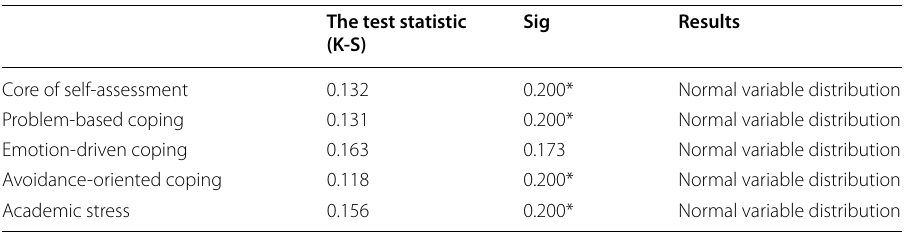
Table 3 Evaluation of normality of variables by Kolmogorov-Smirnov test The test statistic